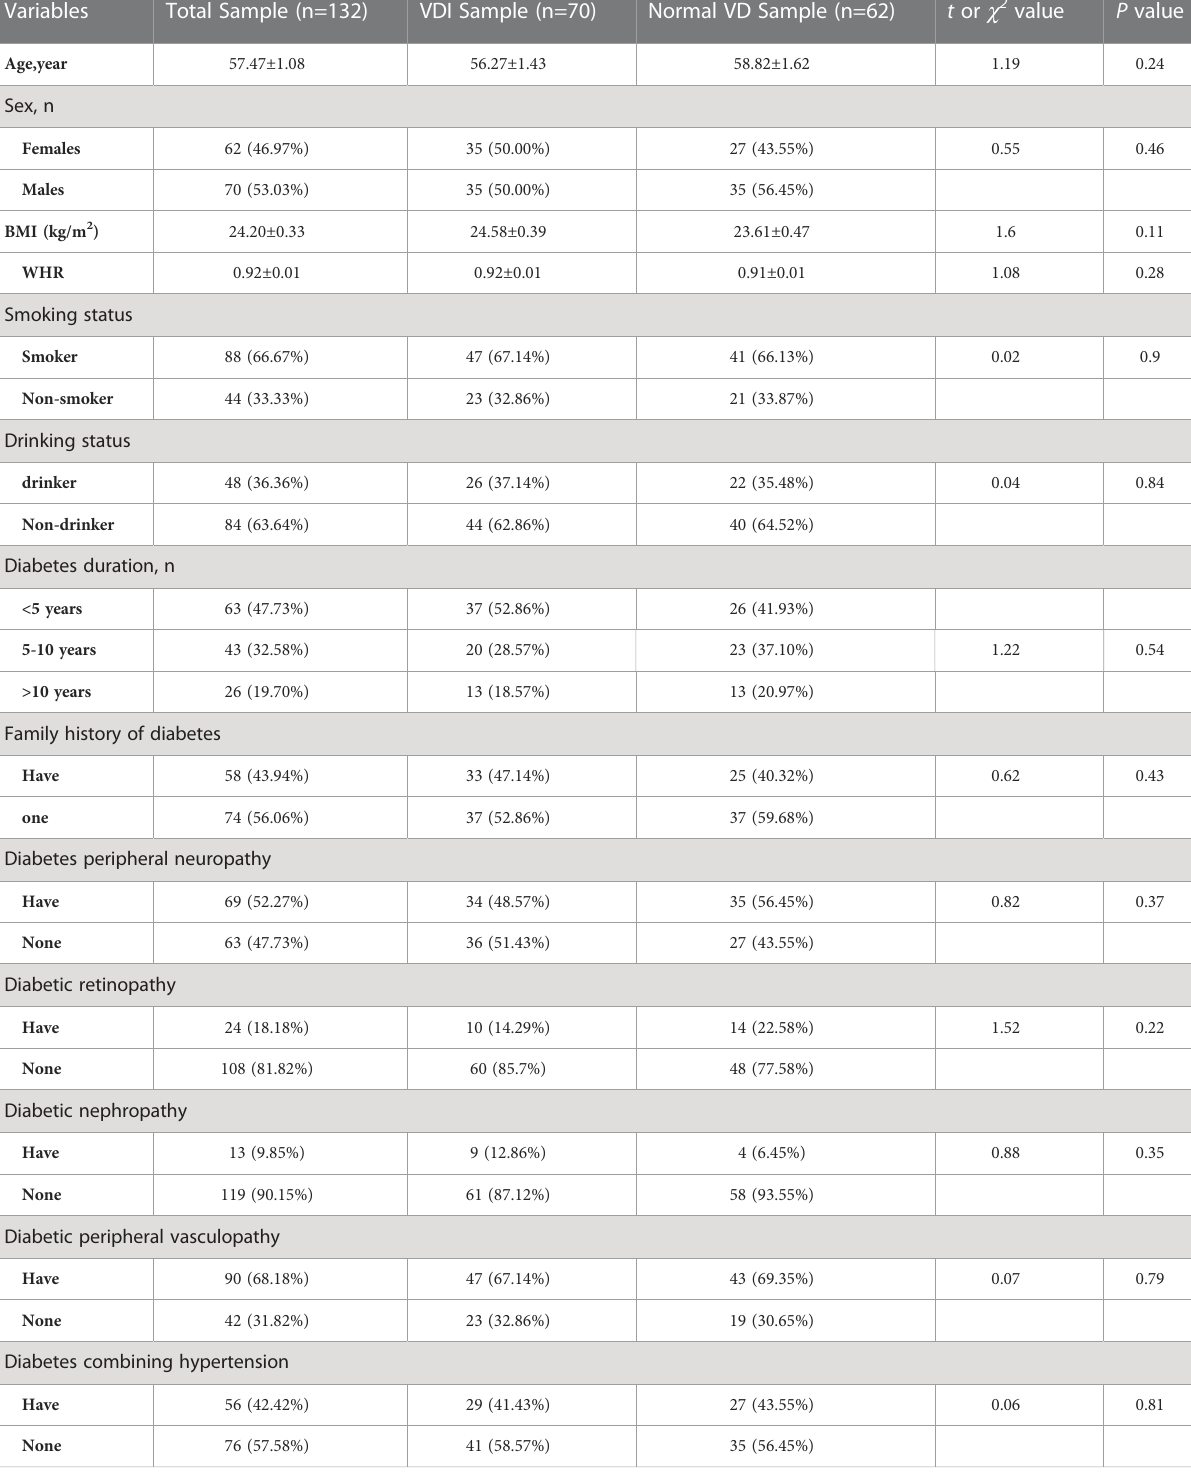
TABLE 1 Information on demographic and medical history in the total sample as well as the VDI and normal VD